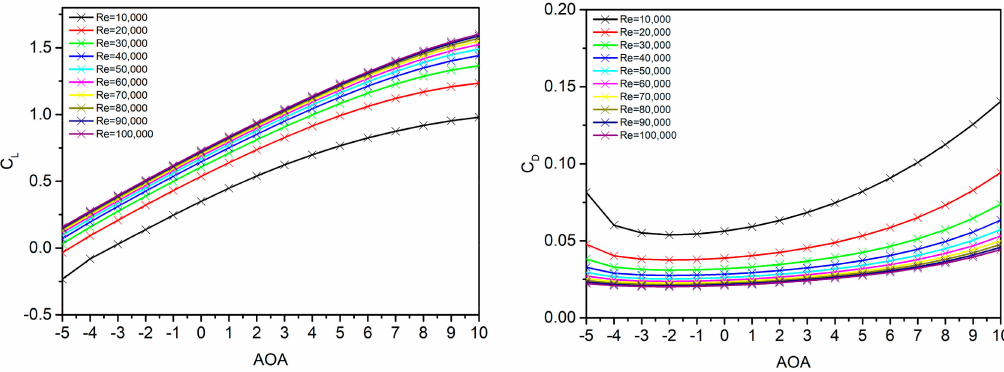
Figure 8. FX63 airfoil performance for Re = 10,000–100,000.